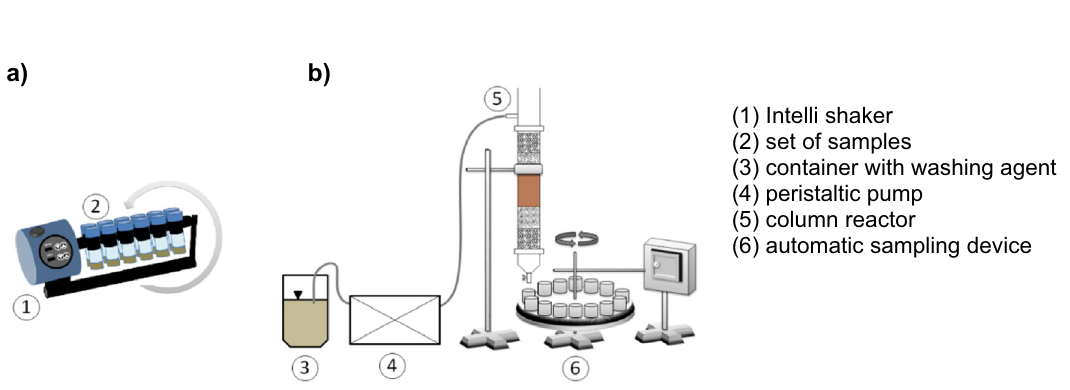
Figure 1. Set-up for metals removal from soil under ( a ) batch and ( b ) dynamic